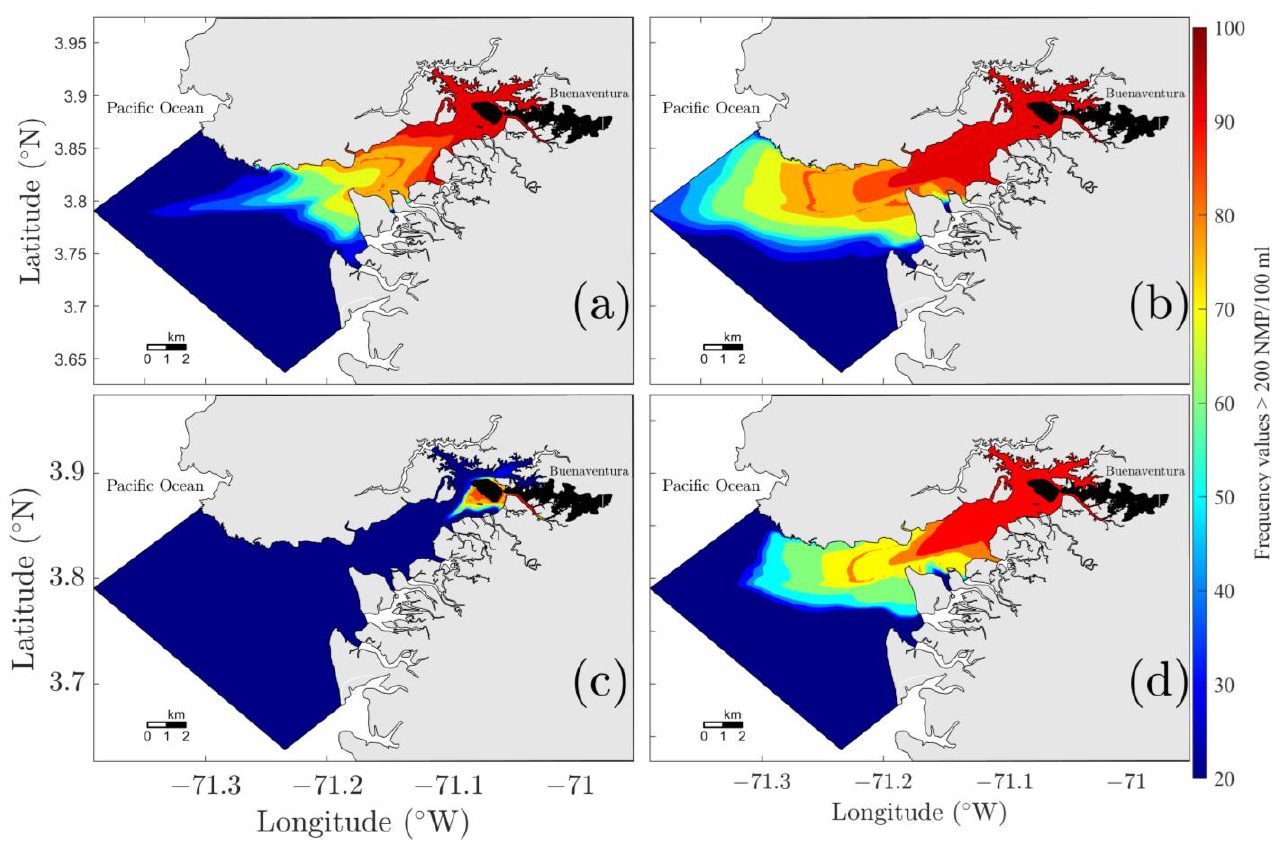
Figure 17. The frequency of areas affected by concentrations higher than 200 MPN/100 mL in different scenarios: ( a ) Scenario two, ( b ) Scenario three, ( c ) Scenario four, and ( d ) Scenario five.